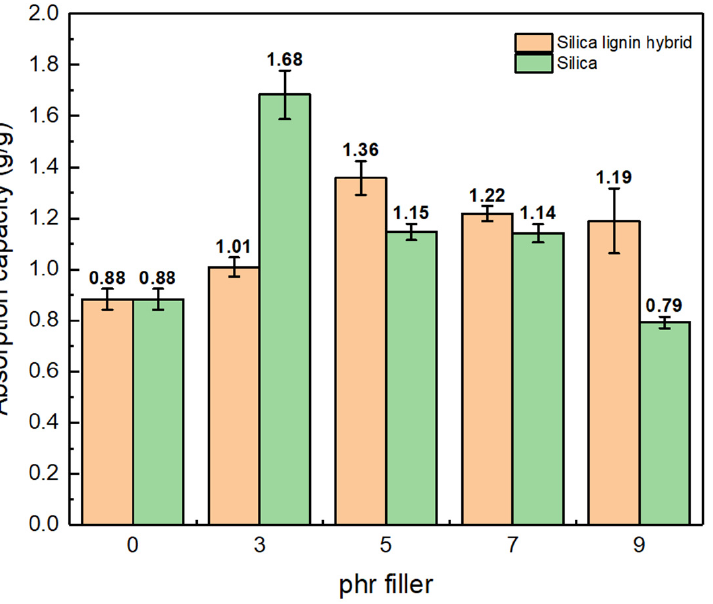
Figure 9. The first cycle of absorption capacity of silica-filled NRF and silica–lignin hybrid-filled NRF at various phr filler